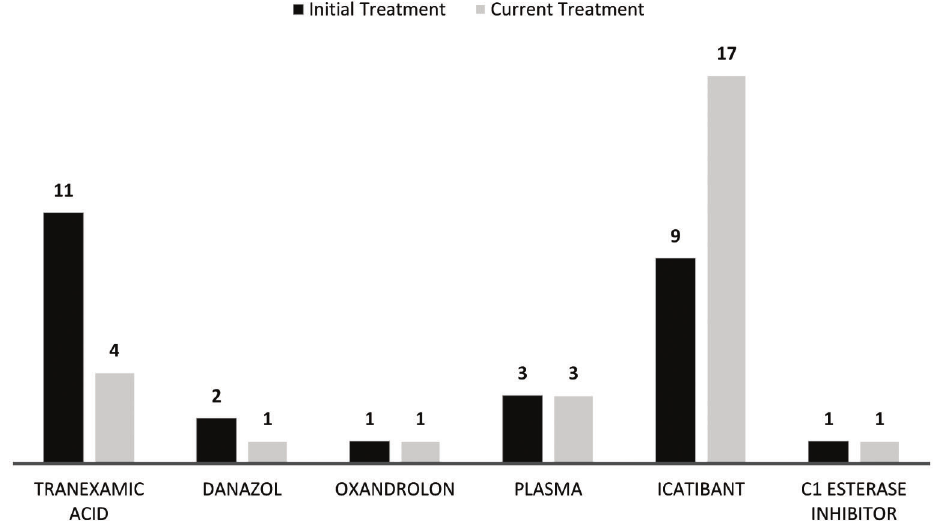
Figure 2. Pro fi le of initial and current treatment of attacks in patients with hereditary